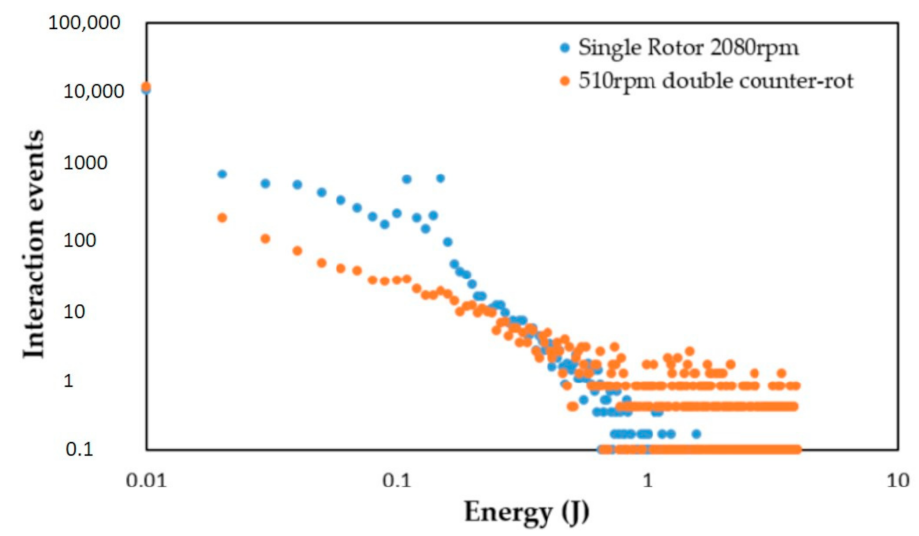
Figure 8. Energy spectra comparing single-rotor at 2080 rpm and double-rotor at 510 rpm, particle size 19.0 + 16.7 mm.